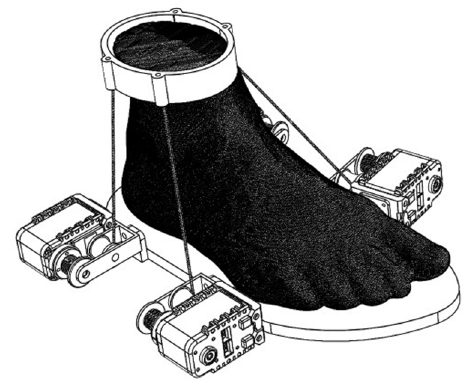
Figure 2. CAD design of CABLEankle as in [27].